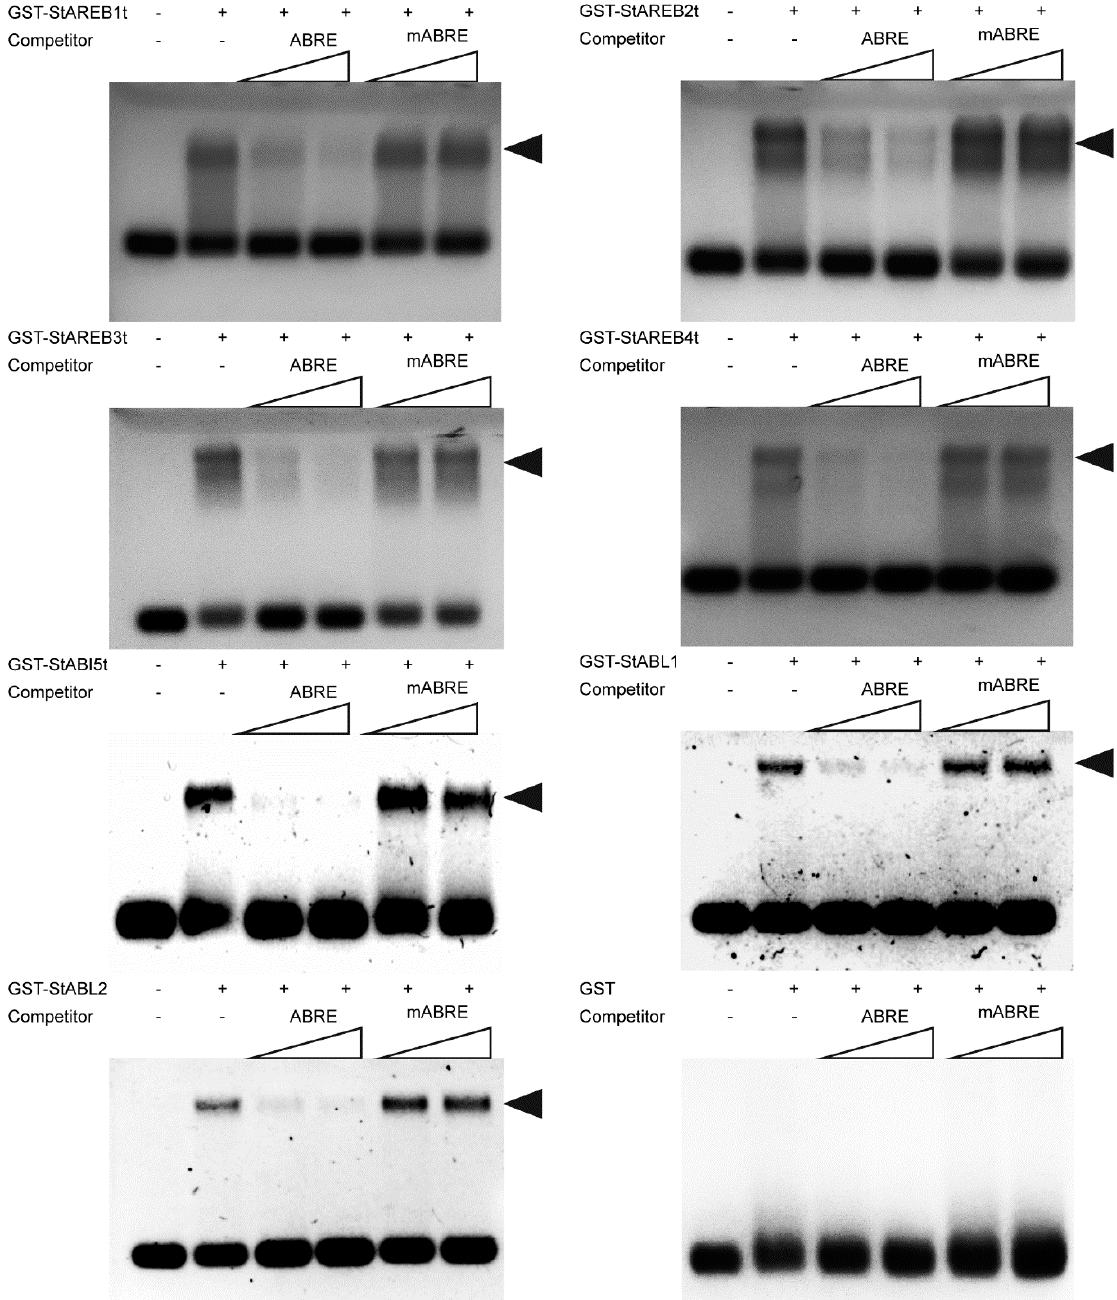
Figure 5. Electrophoretic mobility shift assay (EMSA). The oligonucleotide (ABRE) containing the Em1a element (GGACACGTGGCG) was employed as a FAM-labeled probe in a mobility shift assay. In each assay, 1 μ g of purified recombinant full-length or truncated AREB/ABF/ABI5 was used. The ‘+’ and ‘ − ’ indicate the presence and absence of the indicated probe or protein. Lanes 3 and 4, and 5 and 6 represent a 50-fold and 100-fold molar excess of the specific unlabeled competitor (ABRE) or unlabeled mutated oligonucleotide (mABRE) competitor. Sequences of oligonucleotides are as follows: ABRE, aattccGGACACGTGGCGtaagct; mABRE, aattccGGACctacaGCCtaagct. Shifted bands are indicated by an arrowhead.